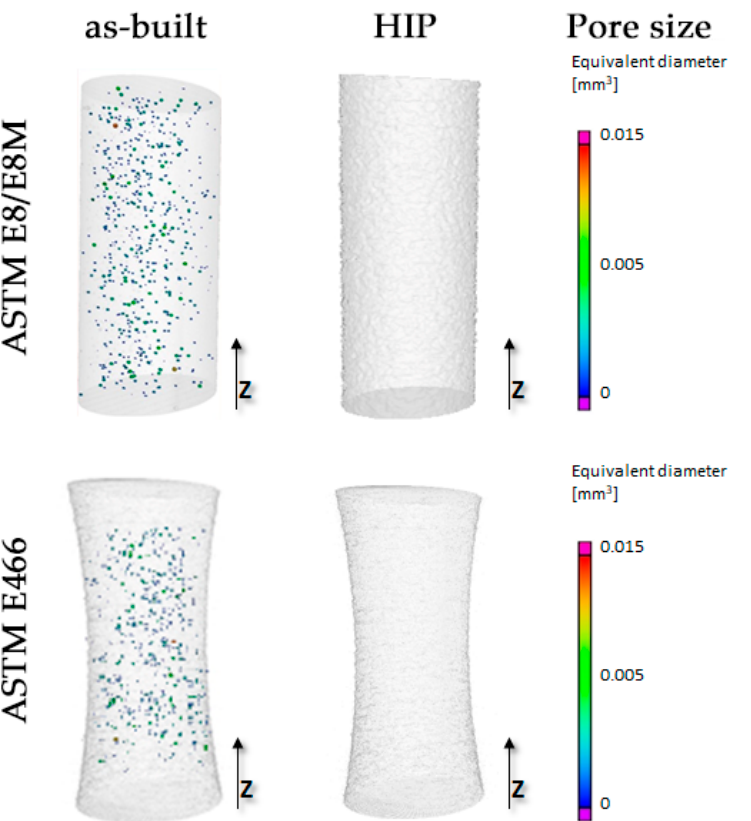
Figure 8. Specimens for the mechanical testing after CT reconstruction in the as-built and HIP state. The specimens in the as-built state had pore sizes larger than the XCT imaging resolu- tion, with a density of >99.9%. For the HIP specimens, no pores with diameters larger than the applied measurement resolution were registered. The measured density values for the analyzed mechanical test samples are shown in Table